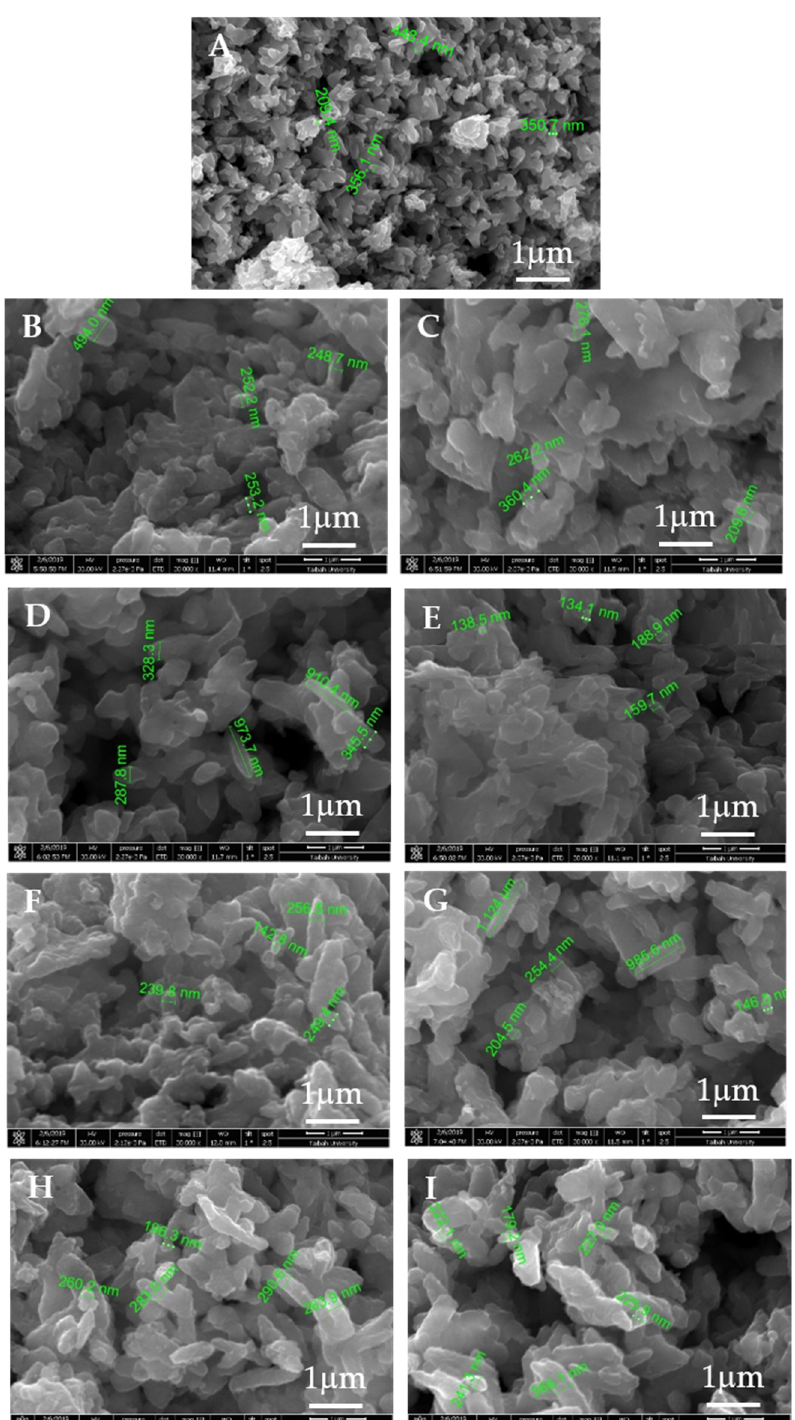
Figure 13. SEM micrographs of iron molybdate (Fe 2 (MoO 4 ) 3 ): ( A ) the starting pure iron molybdate, ( B ) after MB dye removal, ( C ) after the first regeneration, ( D ) after the first removal cycle of MB dye, ( E ) after the second regeneration process, ( F ) after the second removal cycle of MB dye, ( G ) after the